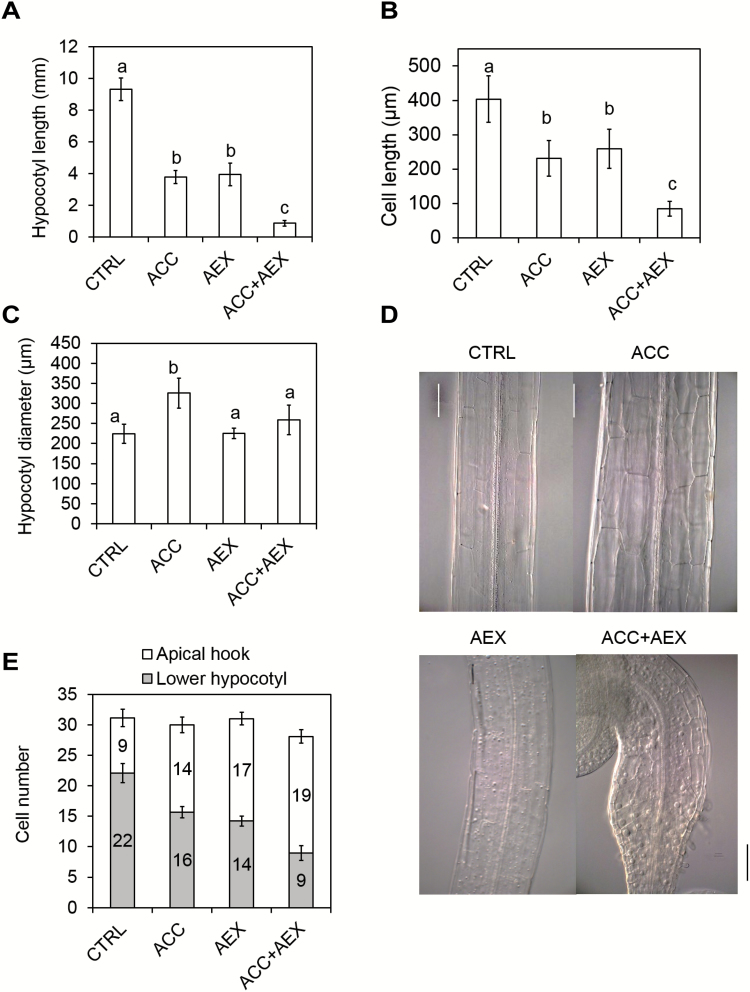
Effect of AEX on apical hook and hypocotyl growth of 4-day-old etiolated Col-0 seedlings, grown on horizontal plates. (A–C) Length (A) and diameter (C) (of the middle part) of hypocotyls and the corresponding length (B) of cortex cells from the middle part of the hypocotyl were measured. (D) DIC images of the middle part of the hypocotyl of 4-day-old etiolated seedlings. From left to right and top to bottom: CTRL, ACC, AEX, AEX+ACC. (E) Numbers of cortex cells along the convex side of the apical hook and the lower part of the hypocotyl. Data are presented as means±SD. Statistical analysis was performed by means of a Kruskal–Wallis rank sum test. Multiple pairwise comparisons were performed with post hoc Wilcoxon’s rank sum tests (P<0.05); P-values were corrected with the Bonferroni correction. Bars with at least one letter in common are not significantly different. Scale bar: 100 µm. (This figure is available in color at JXB online.)